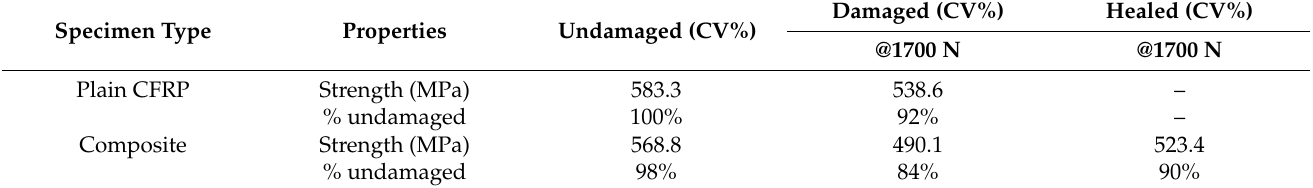
Table 2. Results of flexural four-point bend testing of aerospace composites. Reprinted with permis- sion from [132]. 2007, Elsevier.